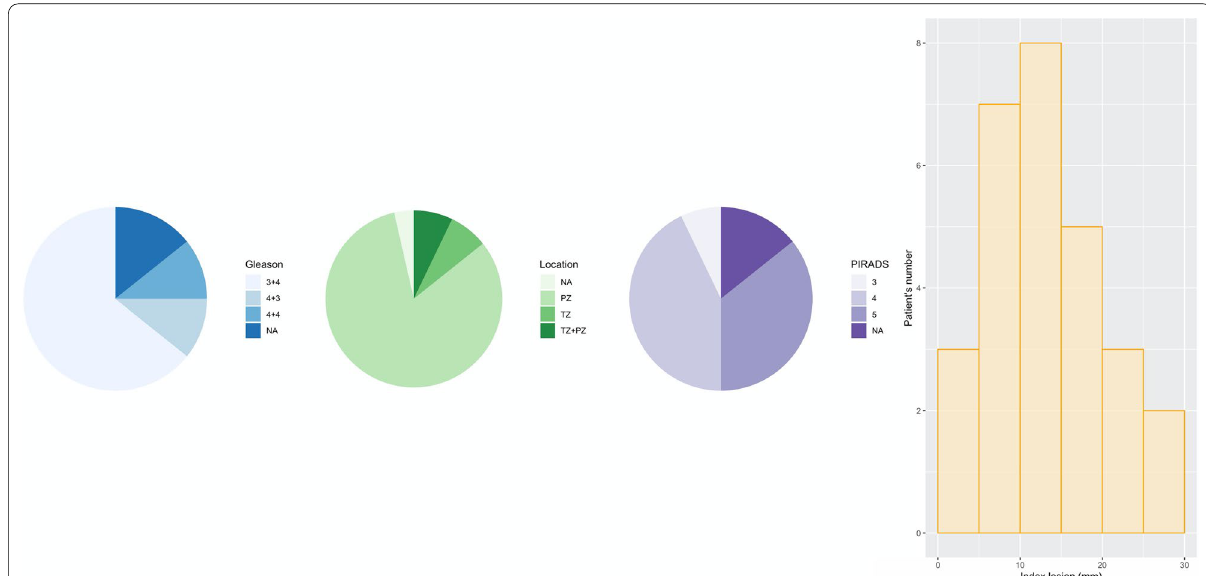
Fig. 1 Descriptive statistics on the tumor characteristics, from left to right: pie charts representing the number of patients within each category of Gleason score, tumor location, and PI-RADS score, where “NA” means that information was not available; histogram showing the tumor index lesion size (maximum length in mm) distribution for the same